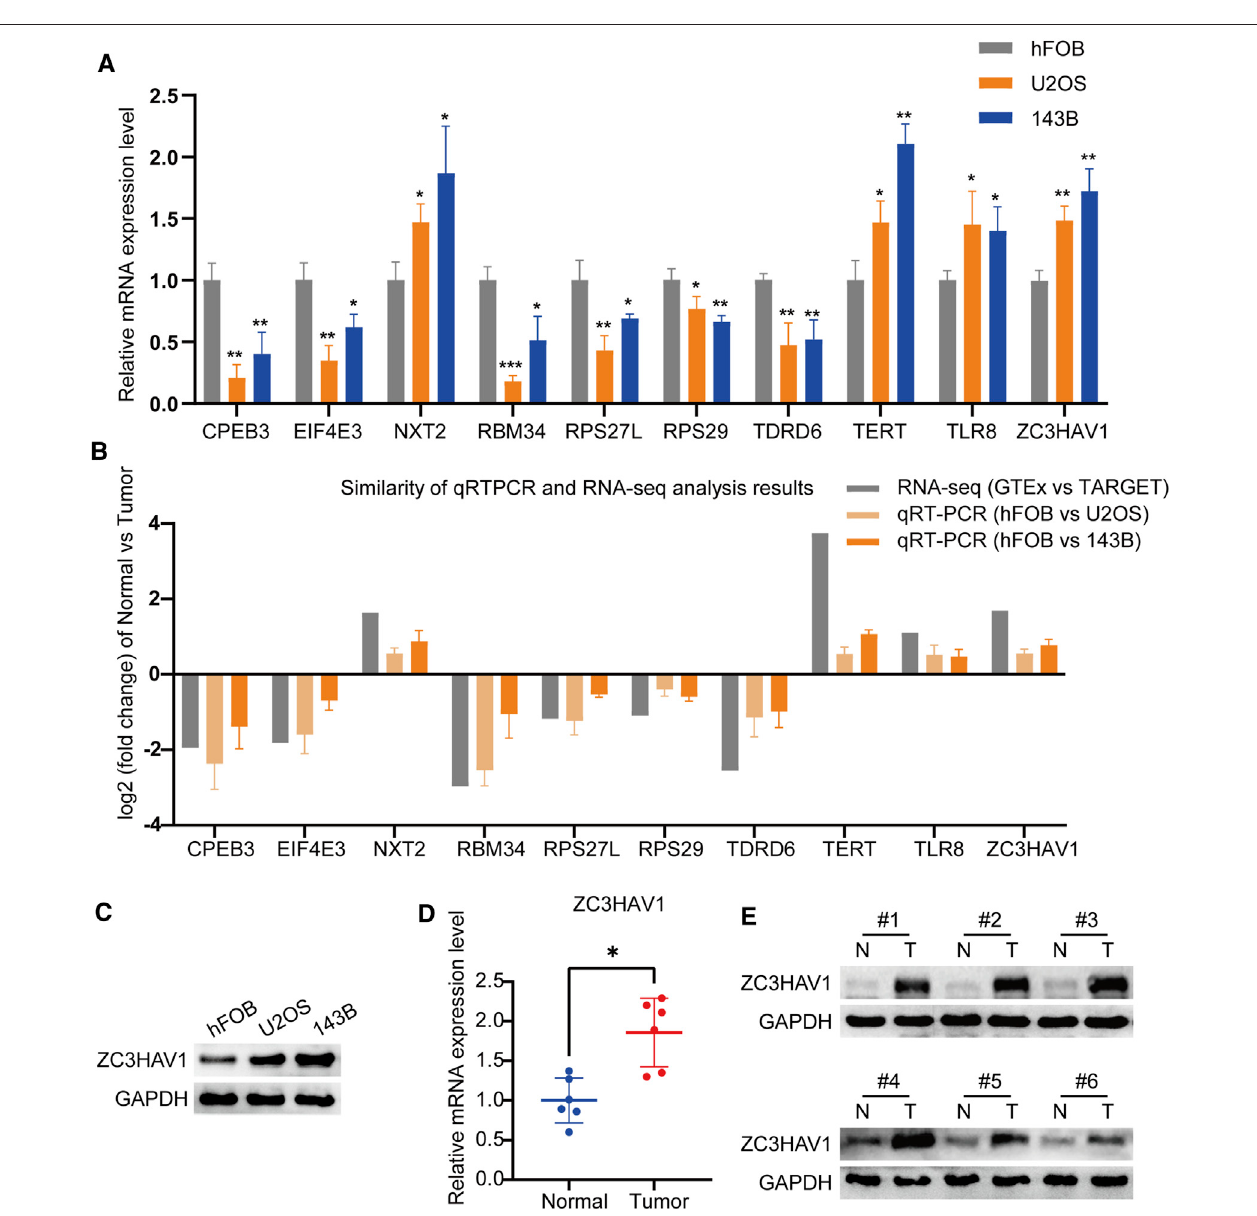
FIGURE 7 | The expression levels of the prognostic RBP genes (A) The qRT-PCR result of the 10 RBP genes was evaluated by the 2- ΔΔ CT method (B) The similarity of qRT-PCR and RNA-sequence analysis results of the 10 RBP genes. The data are expressed as mean ± standard deviation (C) The protein expression of ZC3HAV1 in osteoblast cell line and osteosarcoma cell lines (D,E) The mRNA and protein expression of ZC3HAV1 in six paired osteosarcoma tissues and adjacent normal tissues. * p < 0.05, ** p < 0.01 and *** p < 0.001.